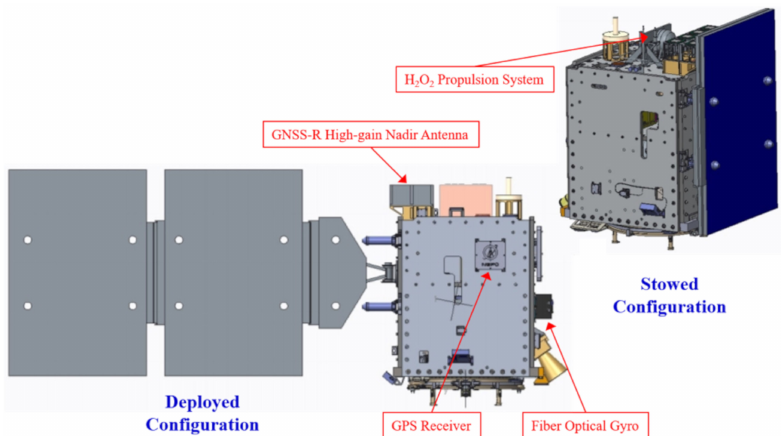
Figure 4. Triton satellite configuration.